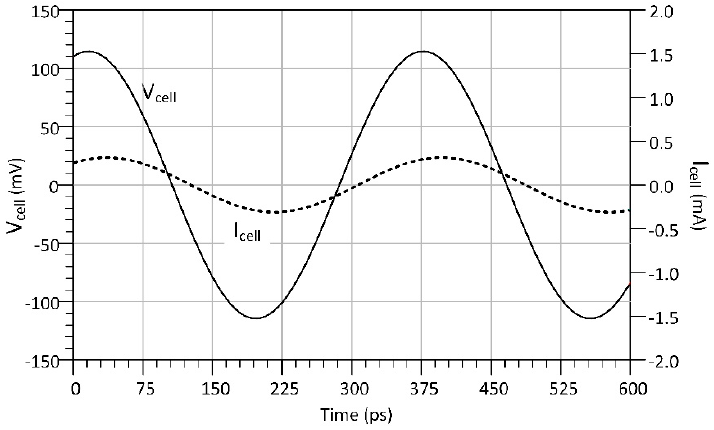
Figure 13. Simulated voltage and current at the input of the resonating cell (see Figure 10b).